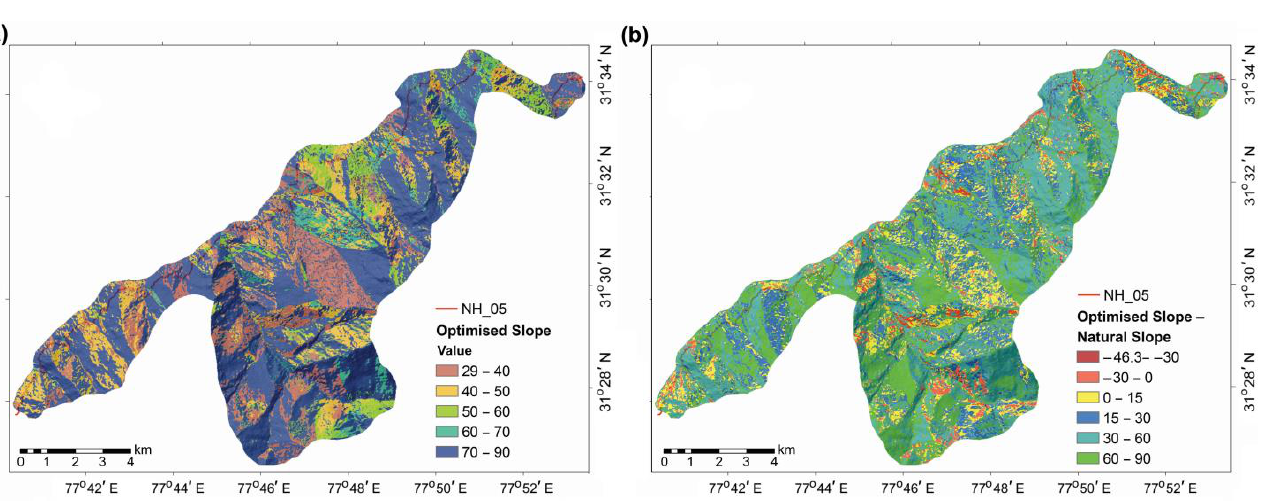
Figure 10. Results of slope optimisation: ( a ) the pixel value represents the slope value needed to maintain a kinematic susceptibility value of 50; ( b ) pixels with negative values need to be flattened by the amount subtracted from the slope angle. Pixels with a positive value may be steepened maximally by the amount indicated without compromising safety.